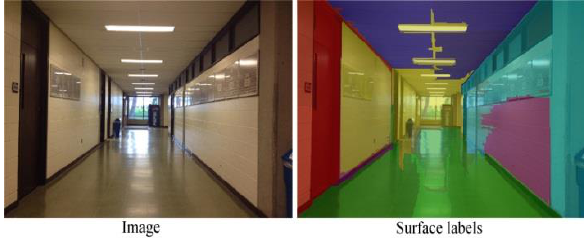
Figure 5. Single image, and the estimated surface